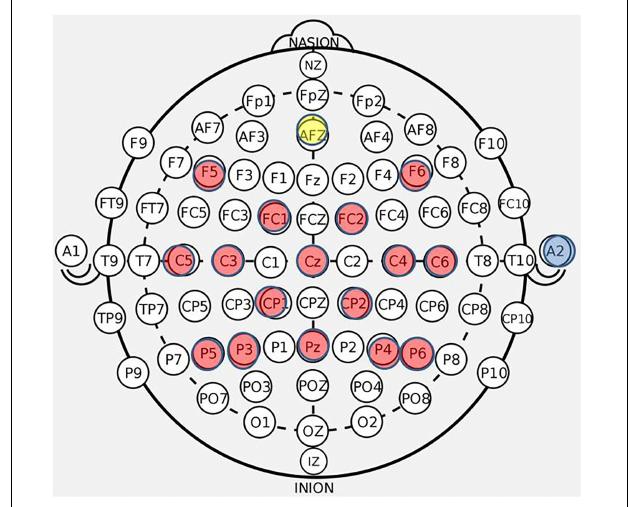
FIGURE 3 | BCI cap array. Electrode array and cap arrangement for all n = 21 participants. Control signals generated at C3 and C4 electrodes for right and left hand movement trials, respectively. Ear clip always placed on the right